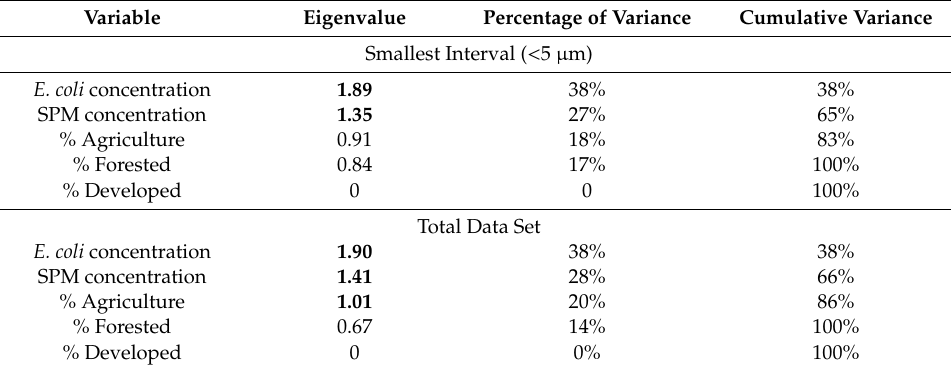
Table 2. Results of principal component analysis comprising 5 components ( E. coli concentration, SPM concentration, percentage of agricultural land use, percentage of forested land use and percentage of developed land use) displaying eigenvalues, percentage of variance and cumulative variance during the study period (20 July 2018–27 October 2018) for the smallest interval ( < 5 µ m) and the total data set across the four monitoring sites in West Run Watershed, West Virginia, USA. Note: bold numbers indicate eigenvalues exceeding 1 (representing